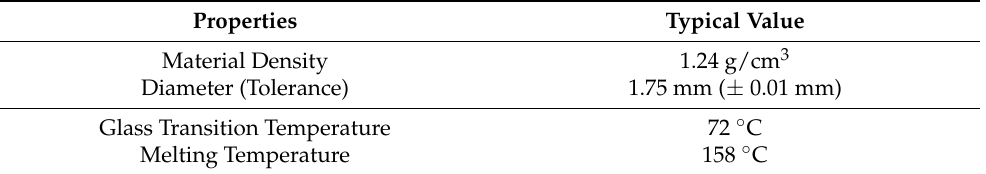
Table 1. Characteristics of the applied PLA-Graphene filament (adapted from manufacturer datasheet, FILOALFA, Italy).